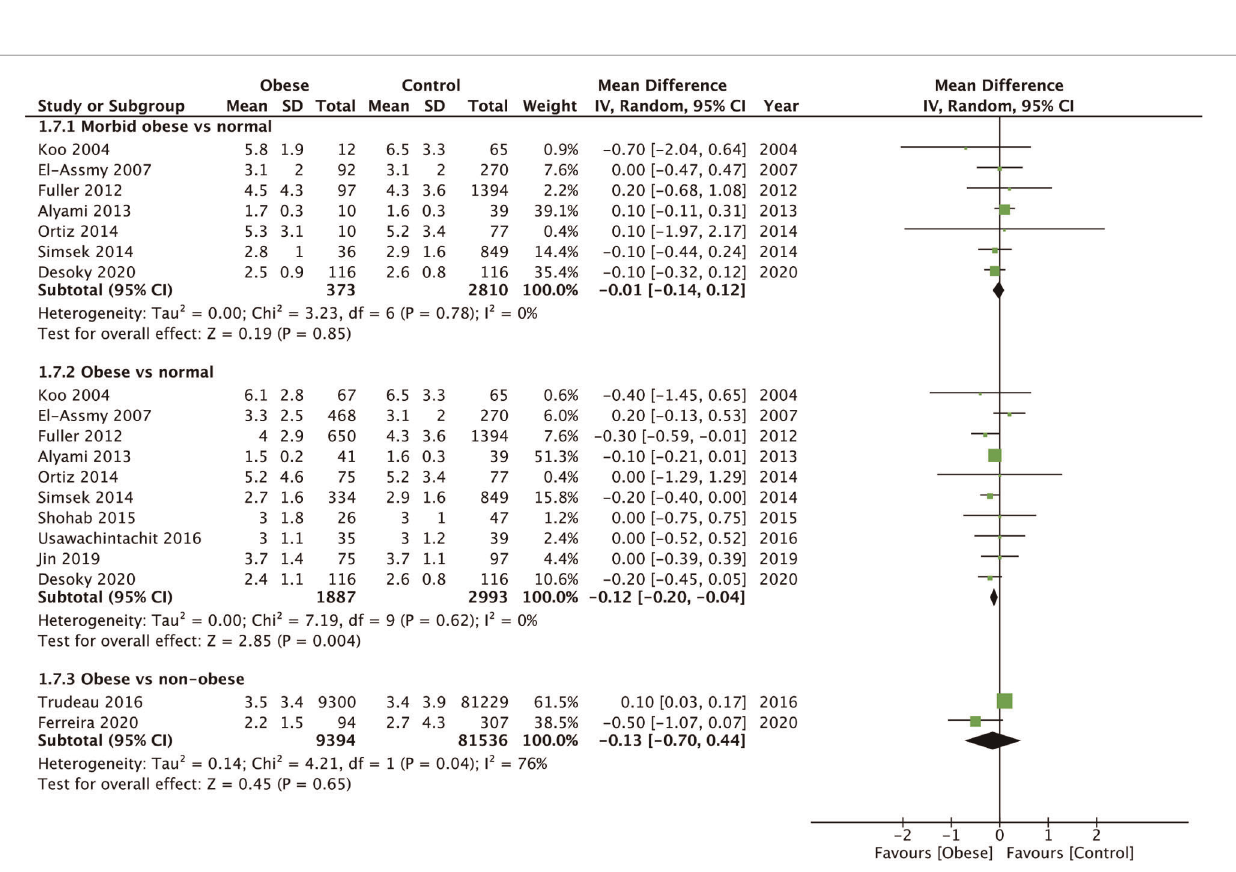
Frontiers in Surgery |